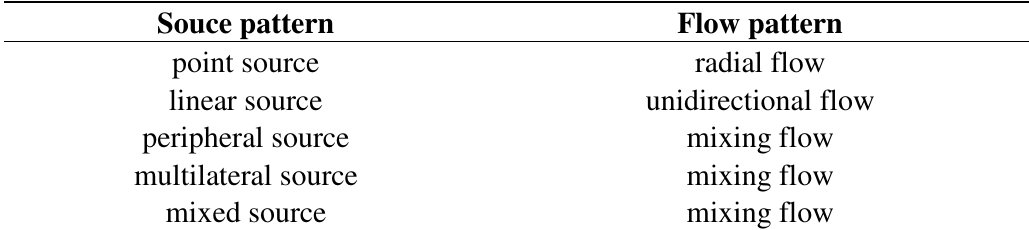
Table 2. Relationship of resin source pattern and resin flow